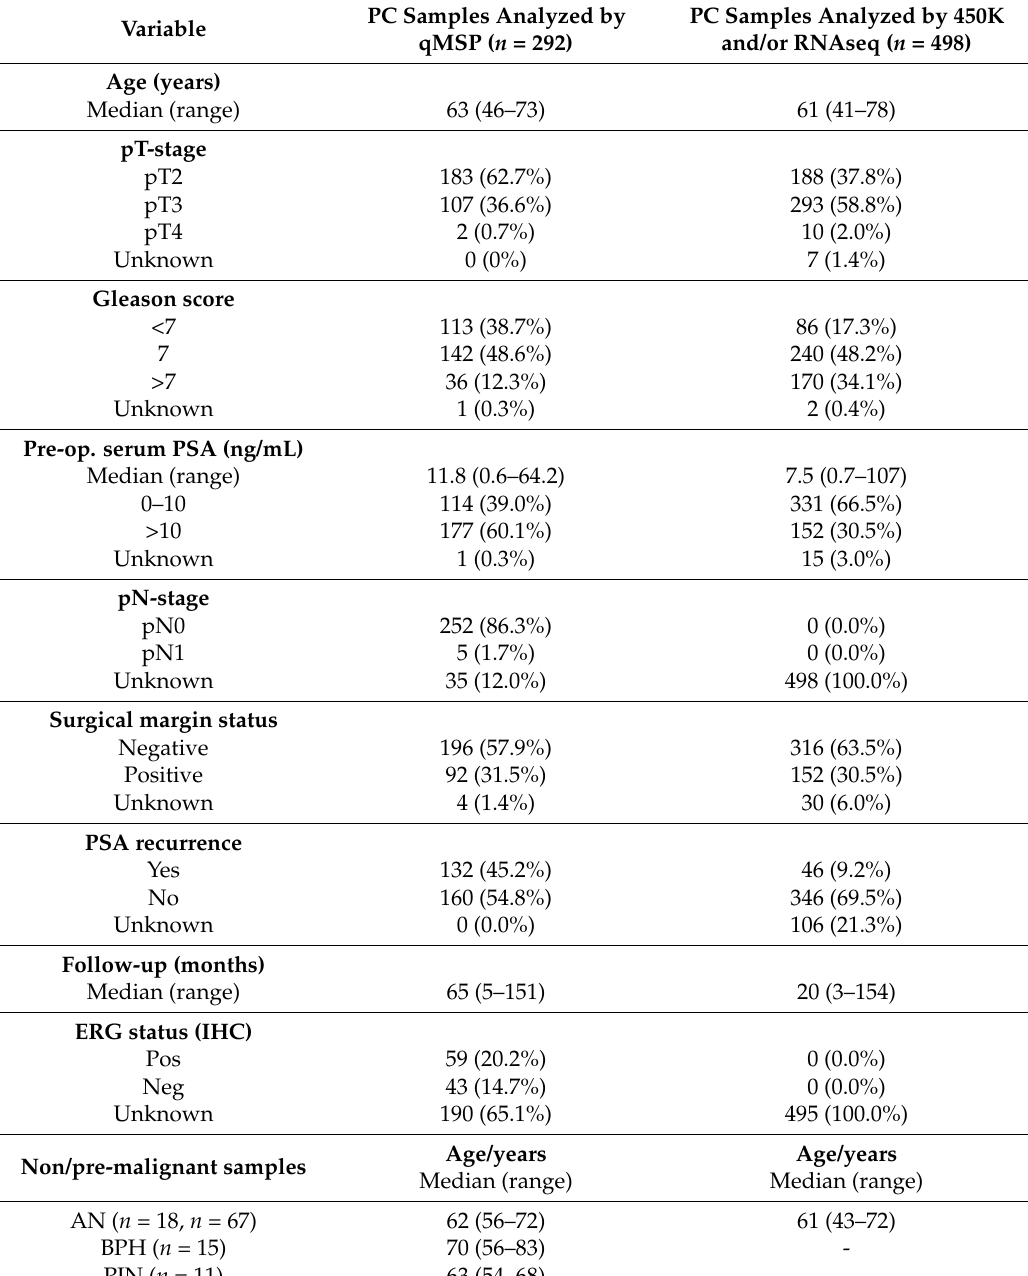
Table 1. Clinicopathologic characteristics of patient samples. For 102 of the patients analyzed by qMSP, ERG status was available from previous IHC analyses. Abbreviations: PC, prostate cancer samples from radical prostatectomies; AN, adjacent normal; BPH, benign prostatic hyperplasia; PIN, prostate intraepithelial neoplasia; pT, pathological tumor stage; Pre-op, preoperative; pN, pathological lymph node stage; IHC, immunohistochemistry; 450K, Illumina 450K DNA methylation array; qMSP, quantitative methylation specific PCR; RNAseq, RNA sequencing; ERG, ERG, ETS transcription factor; PSA, prostate-specific